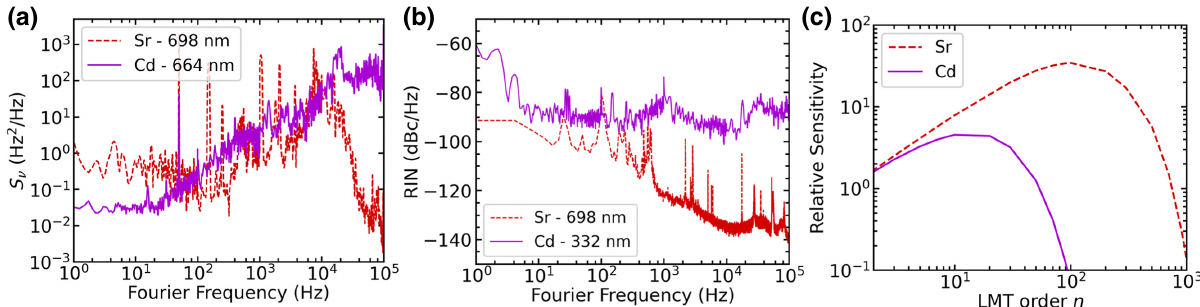
FIG. 5. (a) The measured in-loop S ν ( f ) for the two clock-interferometry lasers at 698 nm and 664 nm for Sr and Cd, respectively: the equivalent fast linewidths are approximately 10 Hz and approximately 2 Hz, respectively. (b) The free-running RIN of the two clock-interferometry lasers. (c) The relative interferometer sensitivity as a function of LMT for the developed laser sources with / 2 π = 1.7 kHz and (cid:6) / 2 π = 740 Hz. In all of the plots, the dashed red lines are for Sr and the τ = 1 μ s and T = 100 ms and (cid:6) Sr Cd solid purple lines are for